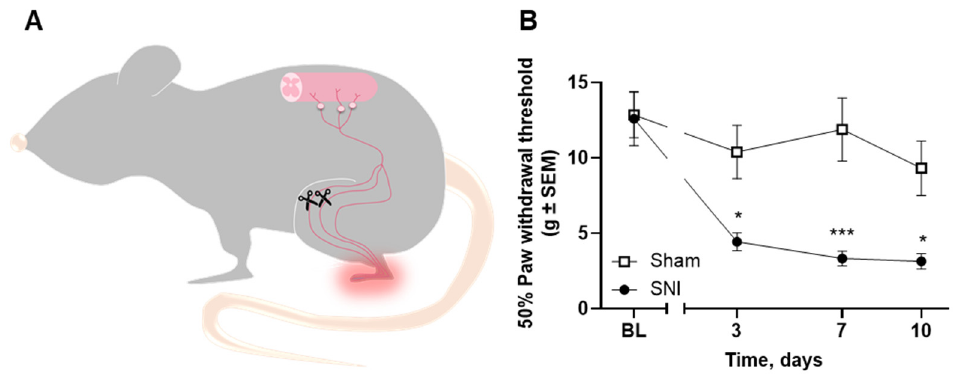
Figure 6. The spared nerve injury (SNI) rat model. ( A ) The SNI rat model of neuropathic pain